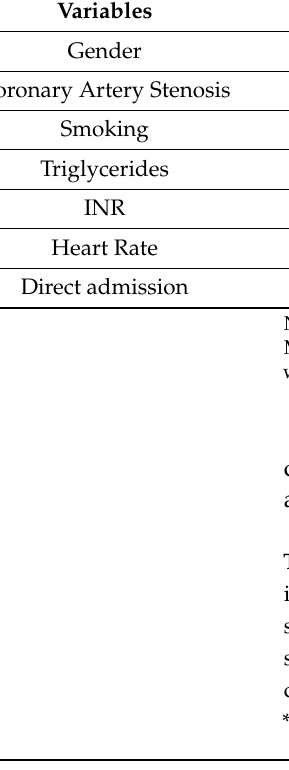
Table 3. Factors associated with stroke severity in the AIS population of Patients with Heart Failure in the age category 65–74 years old. Adjusted OR < 1 denotes factors that are associated with a lower stroke severity (NIH Score ≤ 7), while OR > 1 denotes factors that are associated with a higher stroke severity (NIH Score > 7). Hosmer-Lemeshow test ( p = 846), Cox & Snell (R 2 = 0.229). The overall classified percentage of 70.2 % was applied to check for the fitness of the logistic regression model. * Indicates statistical significance ( p < 0.05) with a 95% confidence interval. 95% C.I.